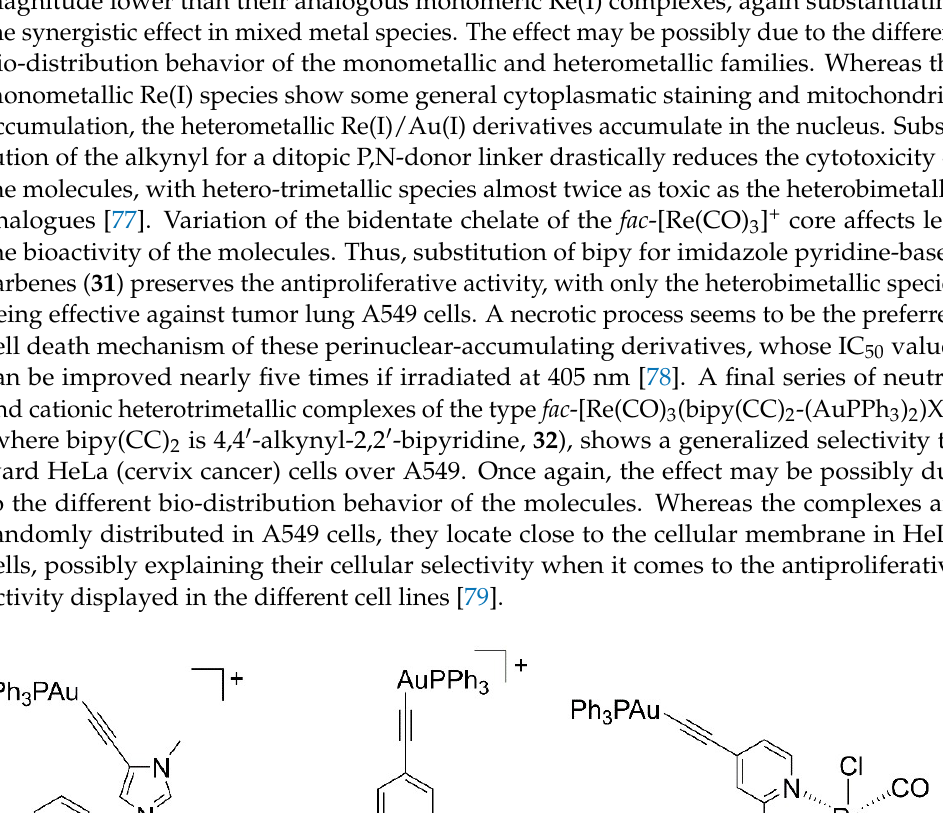
Figure 7. Top: influence of hetero-tri-organometallic compound 33 of Metzler-Nolte and Bandow on the B. subtilis membrane and cell wall integrity. ( a ) GFP-MinD (green fluorescent cell division protein) localization after treatment with molecule 33 and approved antibiotics (valinomycin, gram- icidin S, nisin, and vancomycin). Like valinomycin, gramicidin S, or nisin (positive control), 33 leads to GFP-MinD delocalization, demonstrating membrane depolarization by the molecule. Note that vancomycin here represents the negative control. ( b ) Light microscopy images corresponding to panel a. Bottom: structure of the hetero-tri-organometallic molecule 33 . Figure readapted with per- mission from publisher [80] .